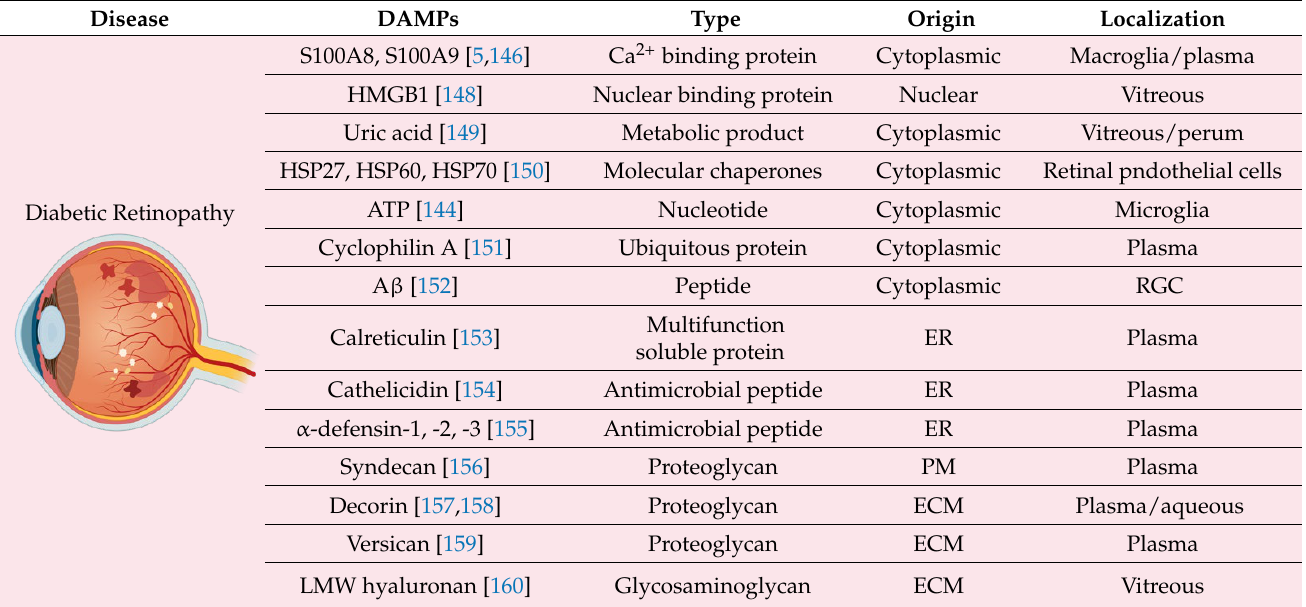
Table 6. DAMPs in diabetic retinopathy.